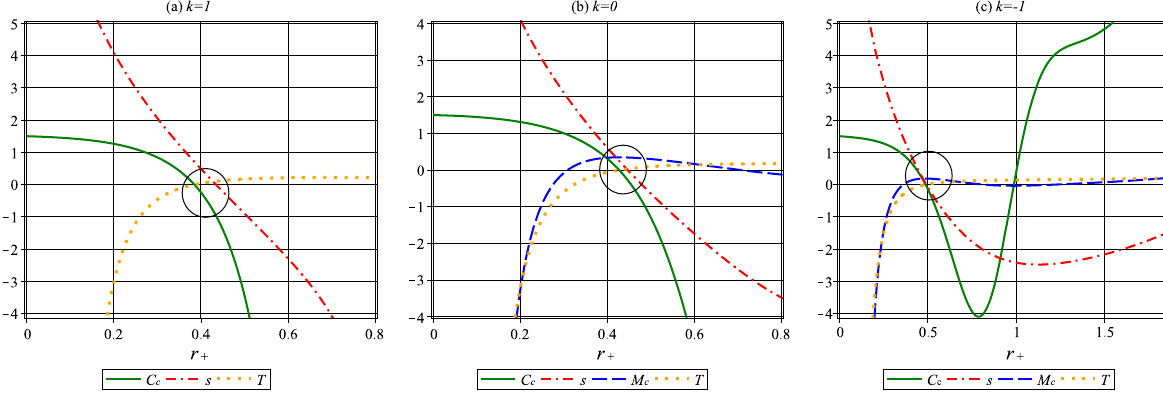
Fig. 13 Logarithmic corrected entropy, mass, specific heat and temperature in terms of r + for g (ε) ≈ 1, f (ε) ≈ 4, m = 1 . 2 and unit value for other model